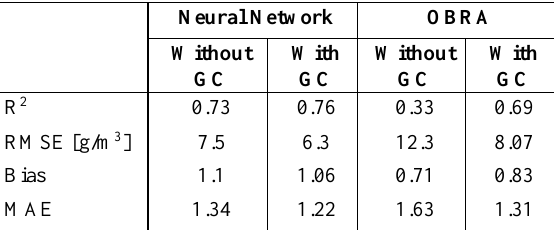
Table 2 . Accuracy statistics of TSM retrieval based on neural network and OBRA models without and with the glint correction (GC).